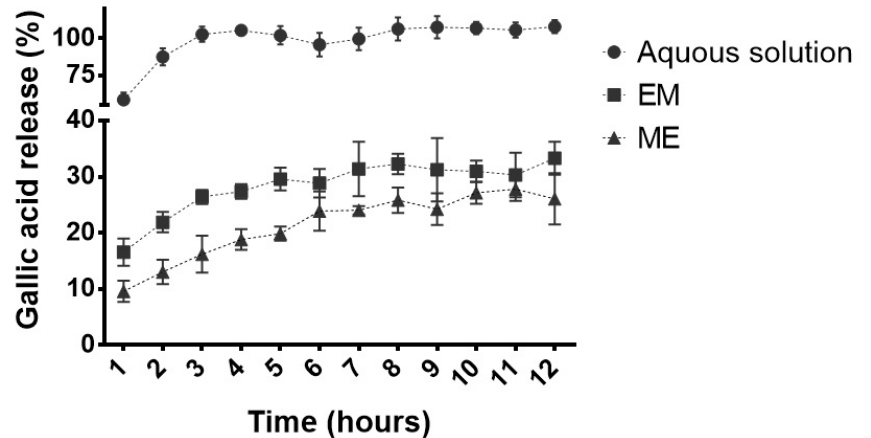
Figure 8. Gallic acid release profile from conventional emulsion (EM) and microemulsion (ME) formulations compared to an aqueous drug solution. All formulations contained 0.05% ( m / v ) of gallic acid ( n = 5).